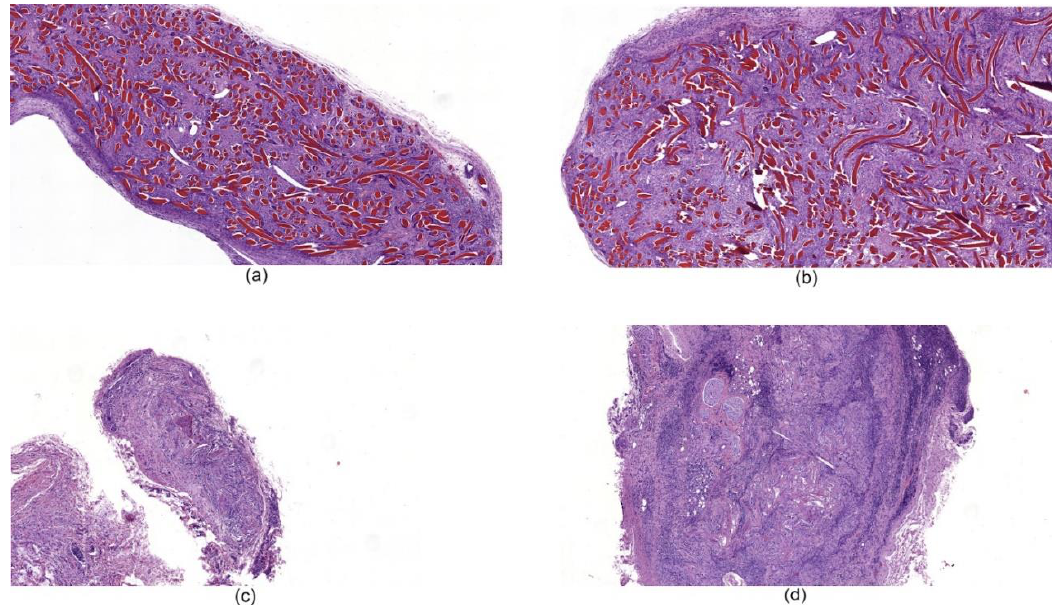
Figure 8. Histological microphotographs of biopsy samples of hemostatic materials taken on the 14th day of the experiment, magnification 50×. ( a ) non-woven chitosan material; ( b ) [chitosan + 0.5% ChNF] non-woven material; ( c ) “Surgicel” hemostatic material; ( d ) “TachoComb” hemostatic material.